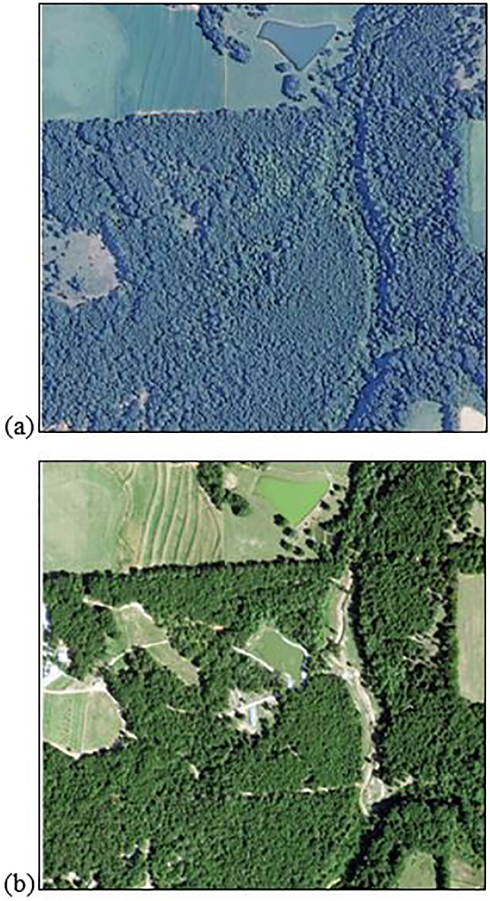
Figure 2. Aerial Imagery of a Portion of Soapstone Branch in (a) 2011 and (b)